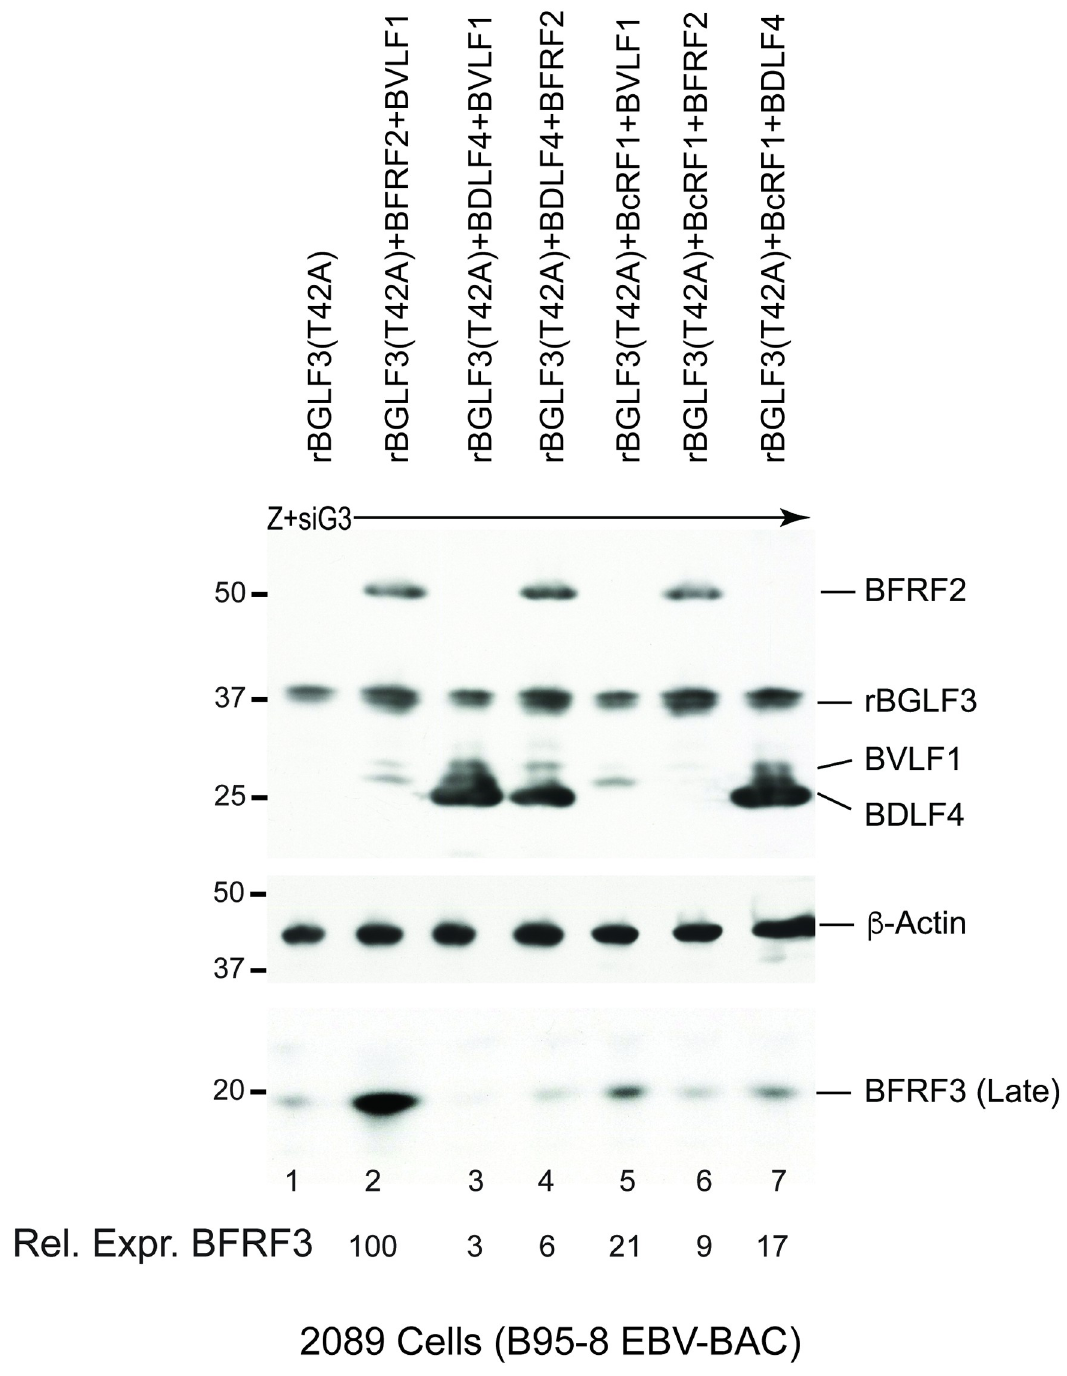
Fig 7. Co-expression of BFRF2 and BVLF1 is sufficient to restore synthesis of late proteins in the presence of BGLF3(T42A). Western blot analysis of 2089 cell lysates demonstrating the ability of BFRF2 and BVLF1 to overcome the BGLF3(T42A) defect in activating late gene expression. Cells were transfected with ZEBRA plus siBGLF3 to knockdown expression of endogenous BGLF3. Lack of endogenous BGLF3 was supplemented by expression of rBGLF3(T42A). Different combinations of the various components of vPIC were co-expressed to restore late gene expression. All late gene regulators were detected with anti-FLAG antibody. β -actin served as a loading control. The membrane was re-blotted with antibody specific to late BFRF3 protein. The capacity of BFRF2 and BVLF1 to suppress the phenotype of BGLF3(T42A) by partially restoring expression of the late BFRF3 protein was reproducible in three biological replicates.